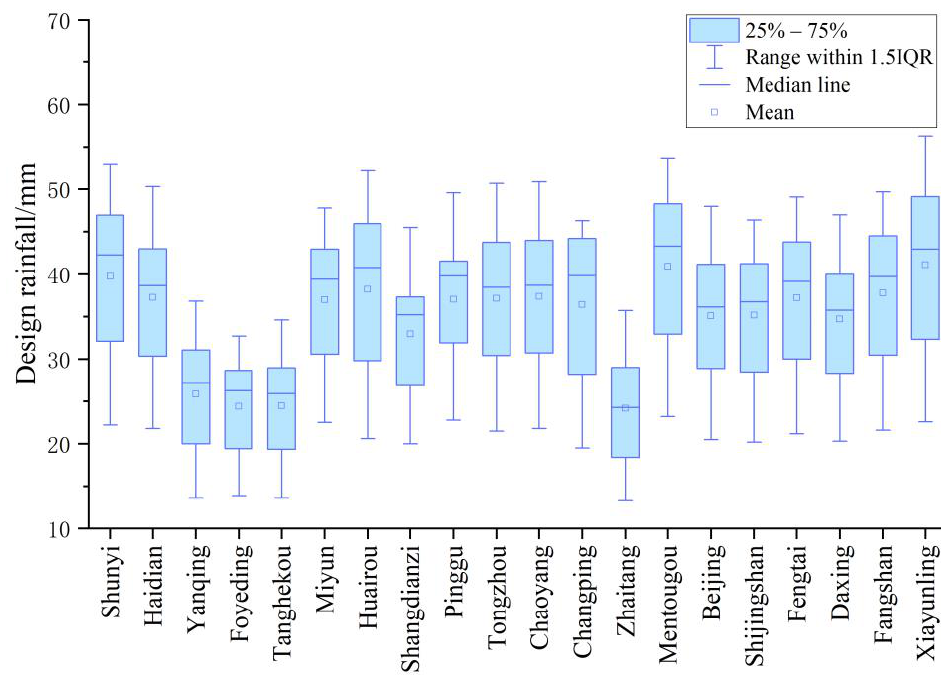
Figure 7. Box plot of the design rainfall (VCR = 85%) in the future.